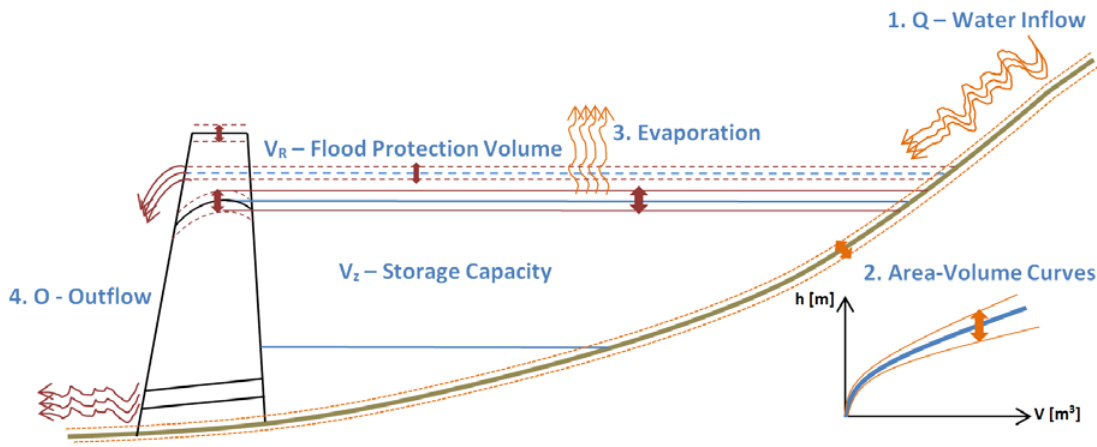
Figure 6. Connection of uncertainties to a complex reservoir design.